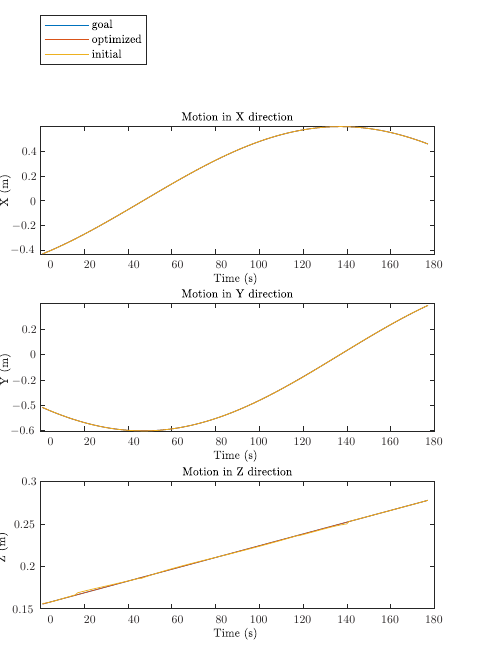
Figure 8. Trajectory tracking of a 3D curved line.